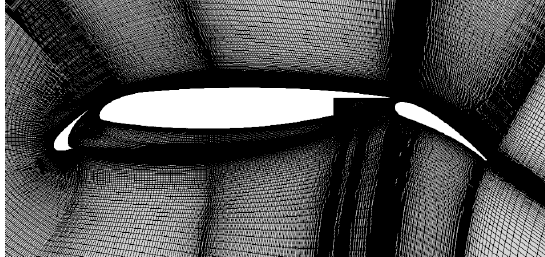
Figure 18. Mesh for calculation of 30P30N airfoil.